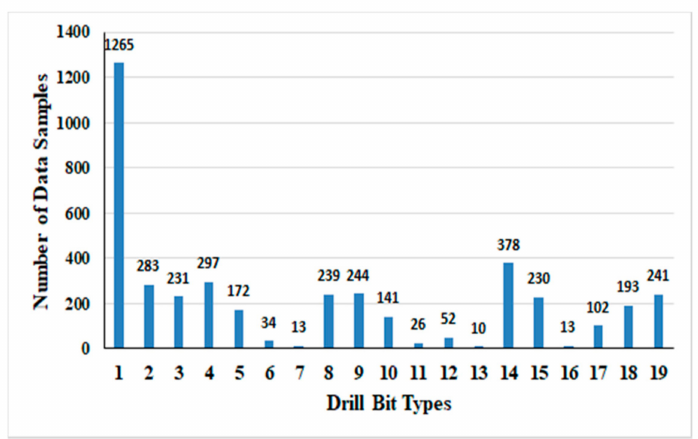
Figure 4. The number of data samples available in real field drilling data for each bit